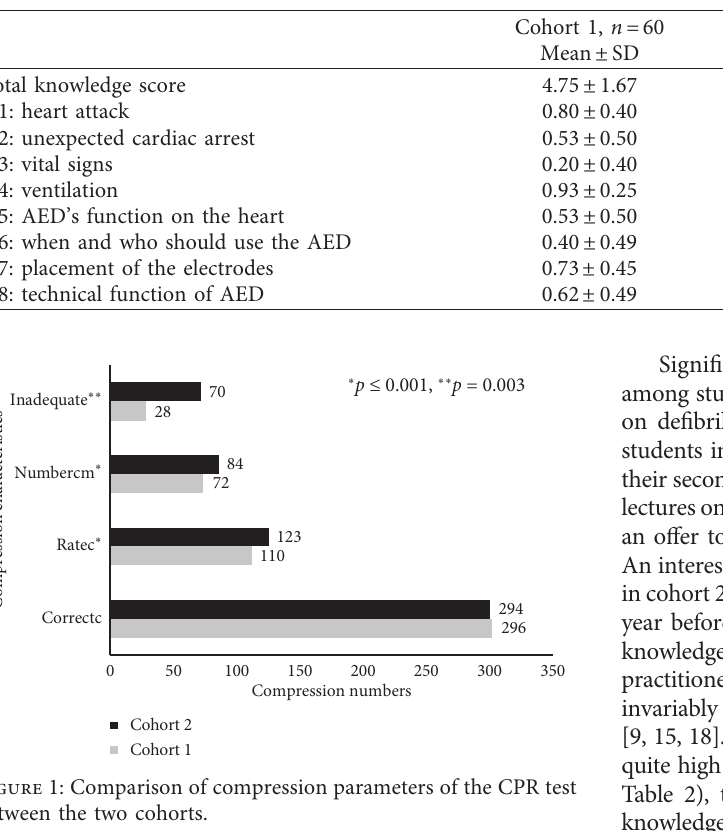
Table 2: Scores on the knowledge test (range 1–8).